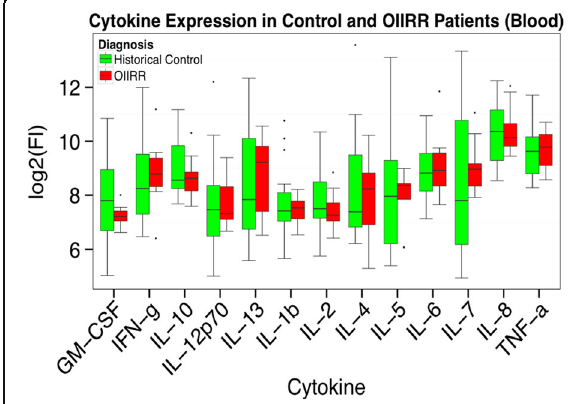
Fig. 4 Showed that cytokine expression from blood samples according to RRG versus